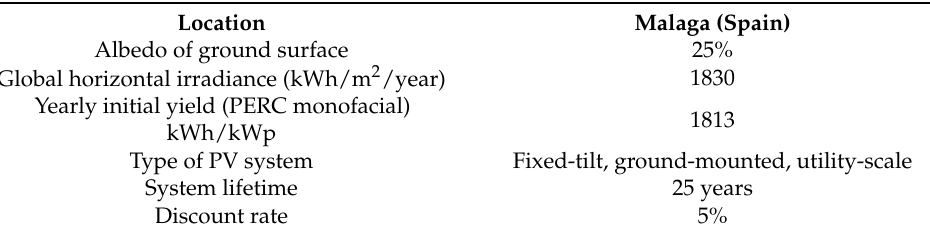
Table 5. General assumptions for LCOE